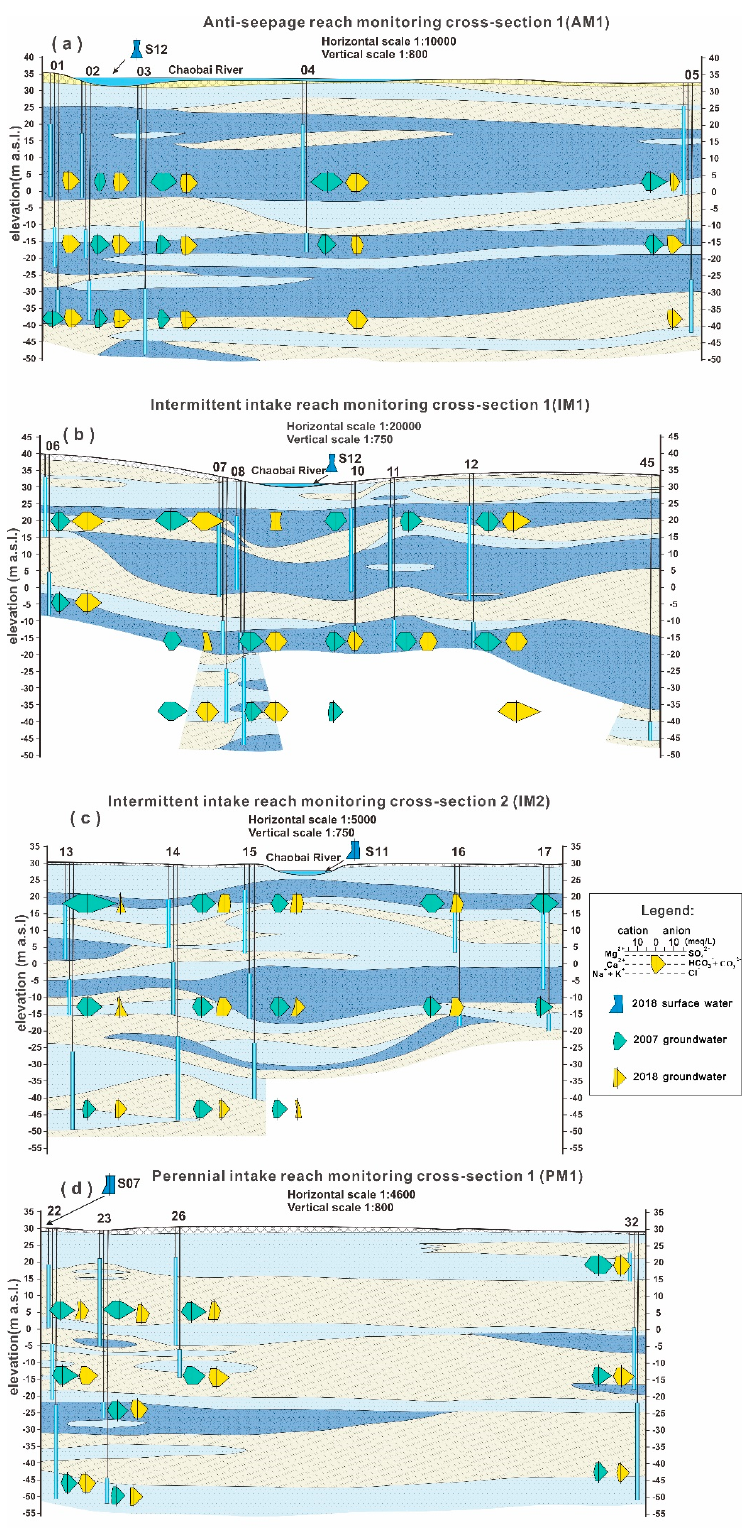
Figure 6. Stiff diagrams of hydrochemical data for the surface water and groundwater at ( a ) Anti- seepage reach monitoring cross-section 1, ( b ) Intermittent intake reach monitoring cross-section 1, ( c ) Intermittent intake reach monitoring cross-section 2, and ( d ) Perennial intake reach monitoring cross-section 1. Blue, green, and yellow stiff diagrams are plotted for surface water sampled in May 2018, groundwater sampled in September 2007 and May 2018, respectively. The symbols of stratum are the same as in Figure